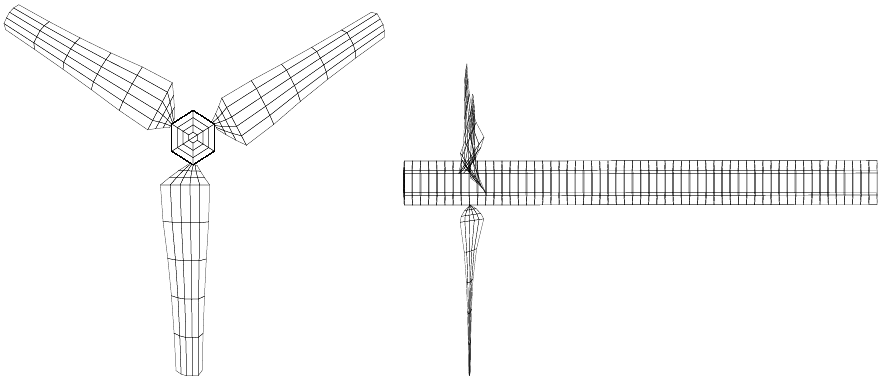
Figure 3. Example of surface mesh for the